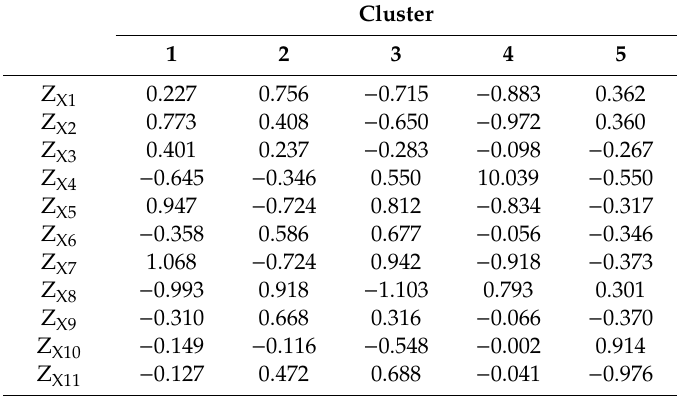
Table 4. Final cluster center results for 190 peaches by k-means clustering analysis.